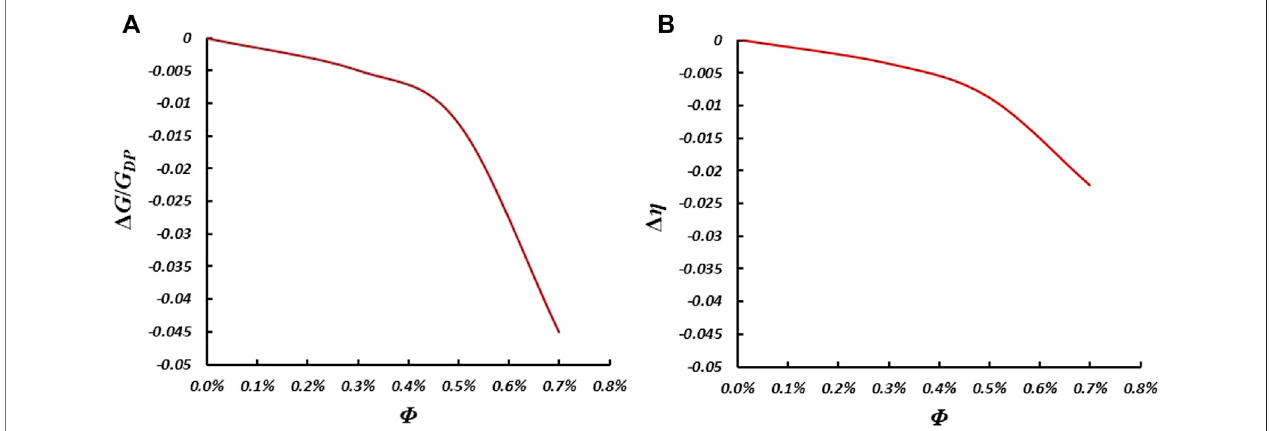
FIGURE 6 | Changing curves of compressor performance parameters related to the seal leakage at design point. Δ G/G DP related to Φ (A) , Δη related to Φ (B) .